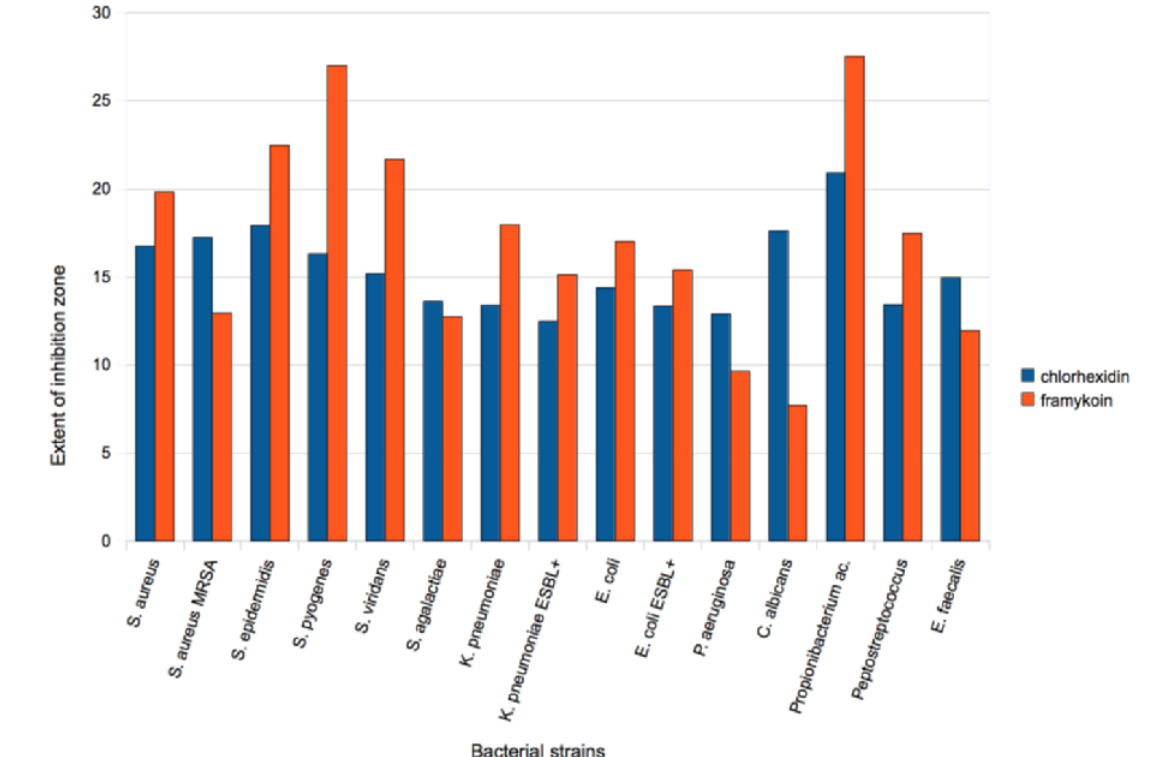
Figure 1. Graphical evaluation of the effectiveness of disinfection agents. The diameters (mm) of the inhibition zones are shown (accurate to 1decimal